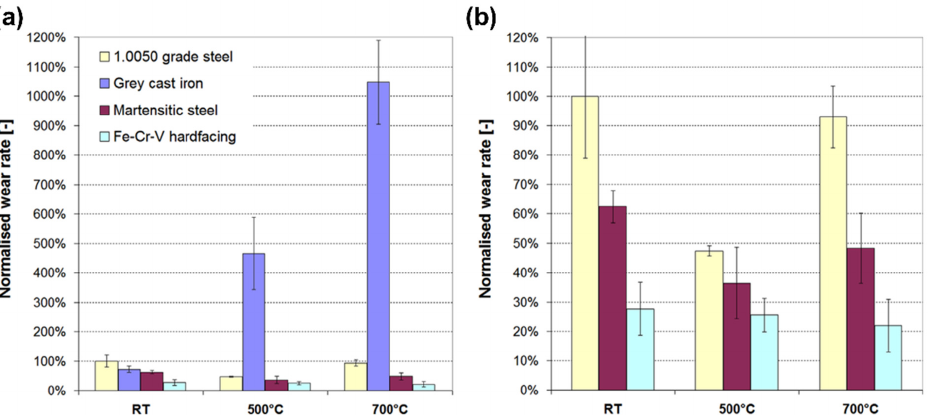
Figure 3. ( a ) Wear rates for various evaluated materials at different temperature normalized on 1.0050 grade steel at room temperature (RT). ( b ) Results after the removal of grey cast iron for better visualization. Reprinted from [107] with permission.